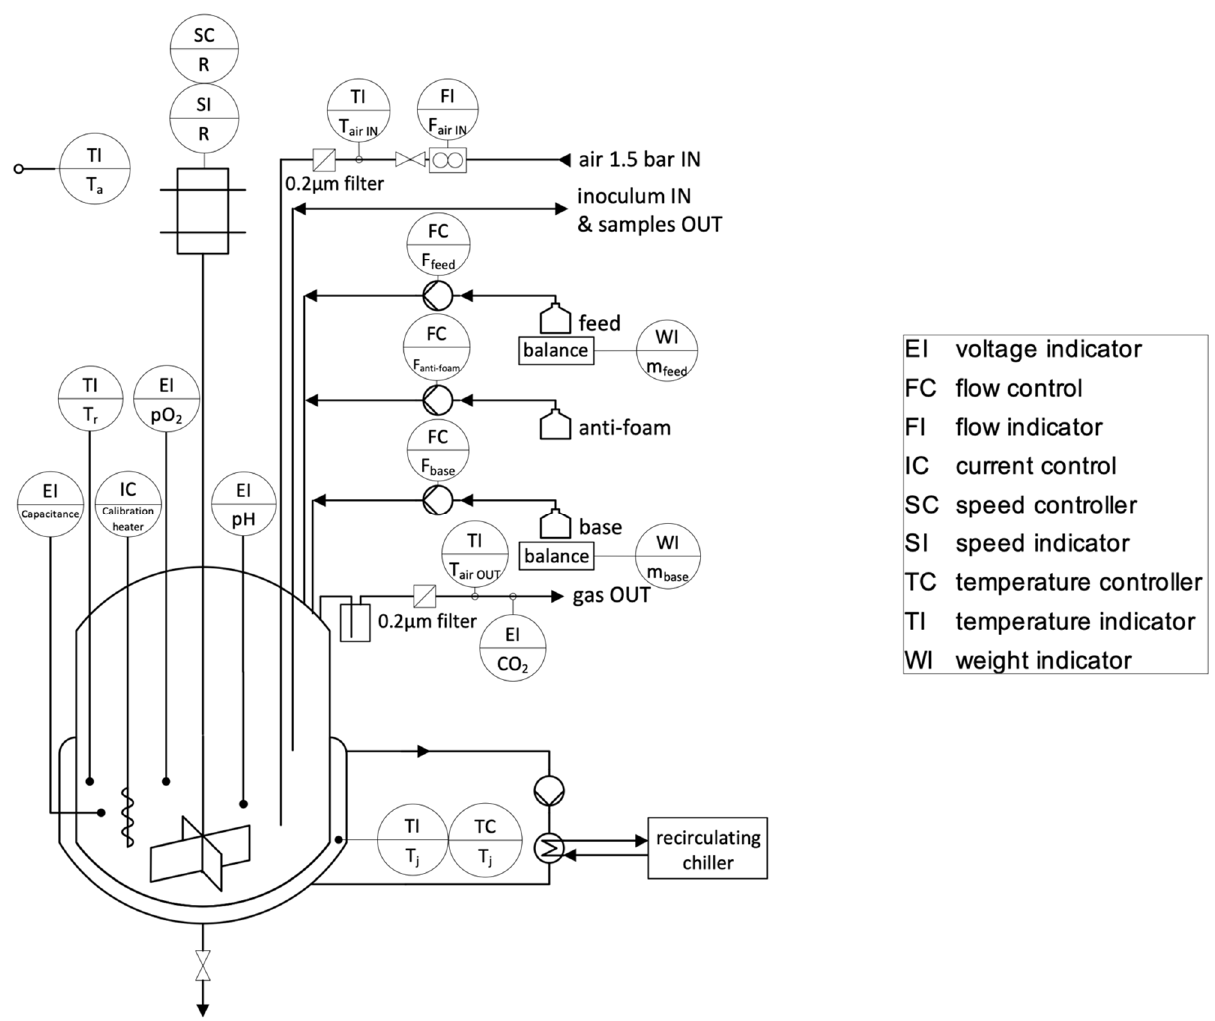
Figure 1. RC1e Biocalorimeter and probes used to perform all